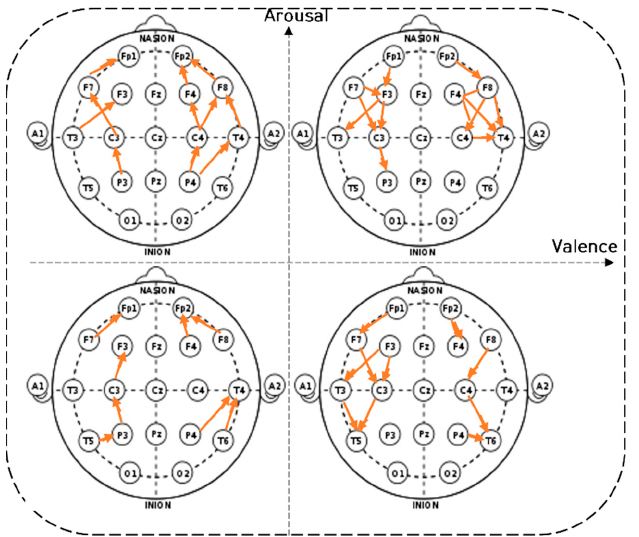
Figure 14. The short-distance connectivity of the prefrontal-temporal lobes, central-parietal lobes, and parietal-temporal lobes (SD connectivity) of the beta wave.